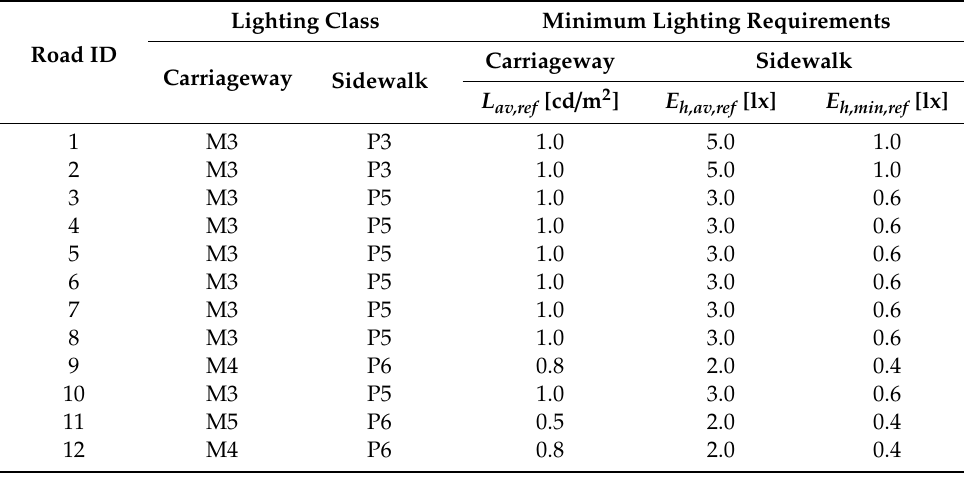
Table 4. Lighting classes and minimum lighting requirements for the 12 selected roads.